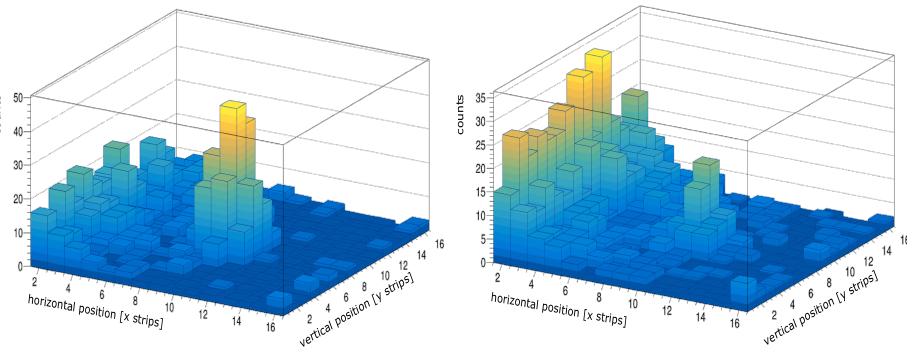
Figure 2. Hit distribution taken with the DSSSD. The left plot shows data for 118 Te at 7 MeV / u that has been taken for 48 h and the right plot shows data of 118 Te at 6 MeV / u taken for 52